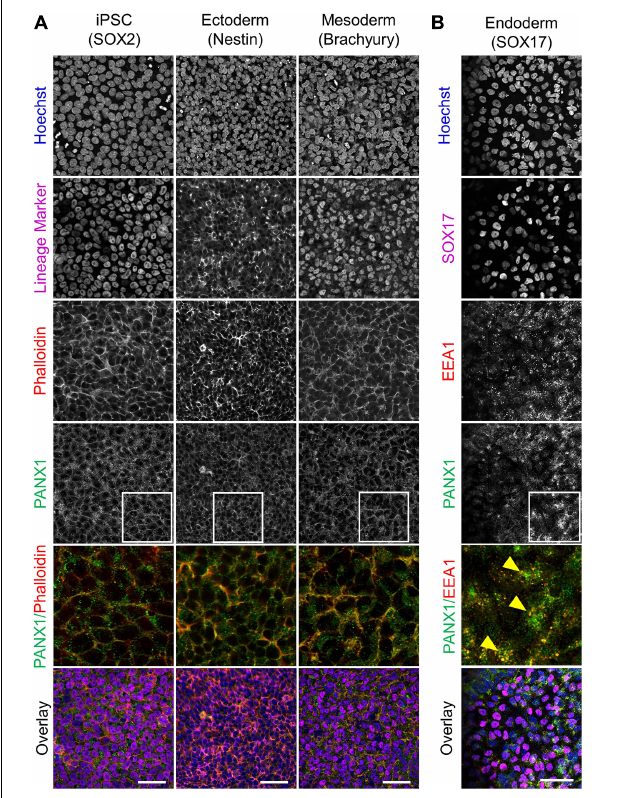
FIGURE 4 | PANX1 is differentially localized in the three embryonic germ layers. (A) Immunofluorescent evaluation of PANX1 (green) demonstrates primarily cell surface localization in iPSCs, ectoderm and mesoderm with lesser intracellular pools. Nuclei (Hoechst, blue); lineage markers (SOX2, Nestin, Brachyury, magenta); Actin (phalloidin, red). (B) In endoderm cells PANX1 is localized intracellularly where it partially overlaps with early endosomes (EEA1, red; SOX17, magenta). Inset: regions of interest zoomed in to highlight regional PANX1 localization. Brightness and contrast were equally adjusted across conditions in FIJI. Scale bar = 50 µ